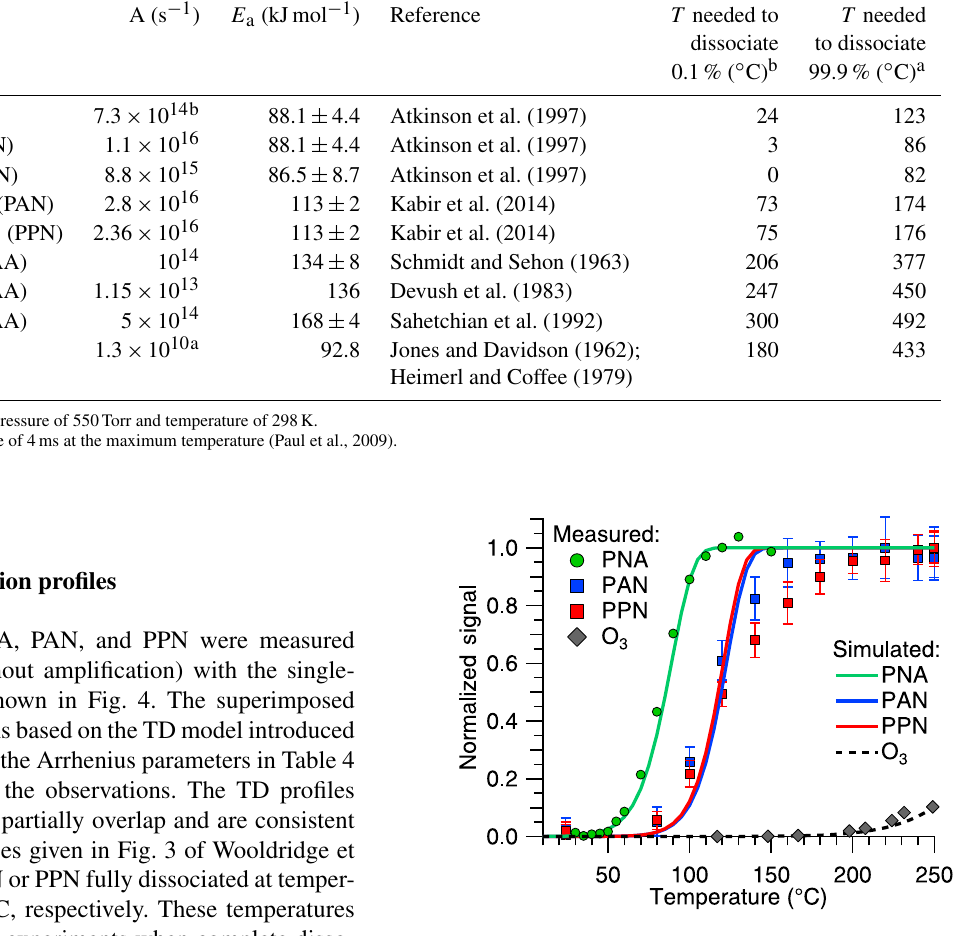
Figure 4. Normalized thermal dissociation profiles of PNA, PAN, PPN, and O 3 as a function of inlet set temperature. Superimposed trend lines are simulations based on the TD model introduced by Paul et al. (2009). The PNA, PAN, and PPN data were observed by TD-CRDS without amplification gases present, whereas the O 3 data were observed by TD-PERCA-CRDS. The error bars represent standard deviations of 1s